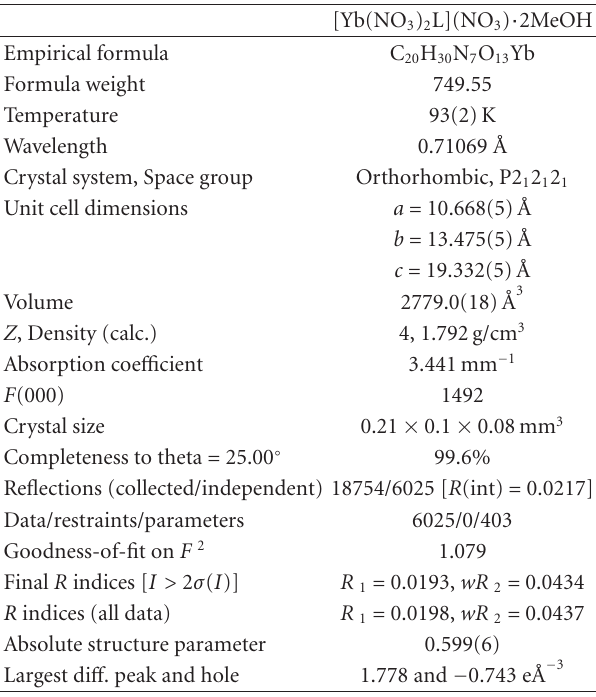
Table 1: Crystal data and structure refinement for